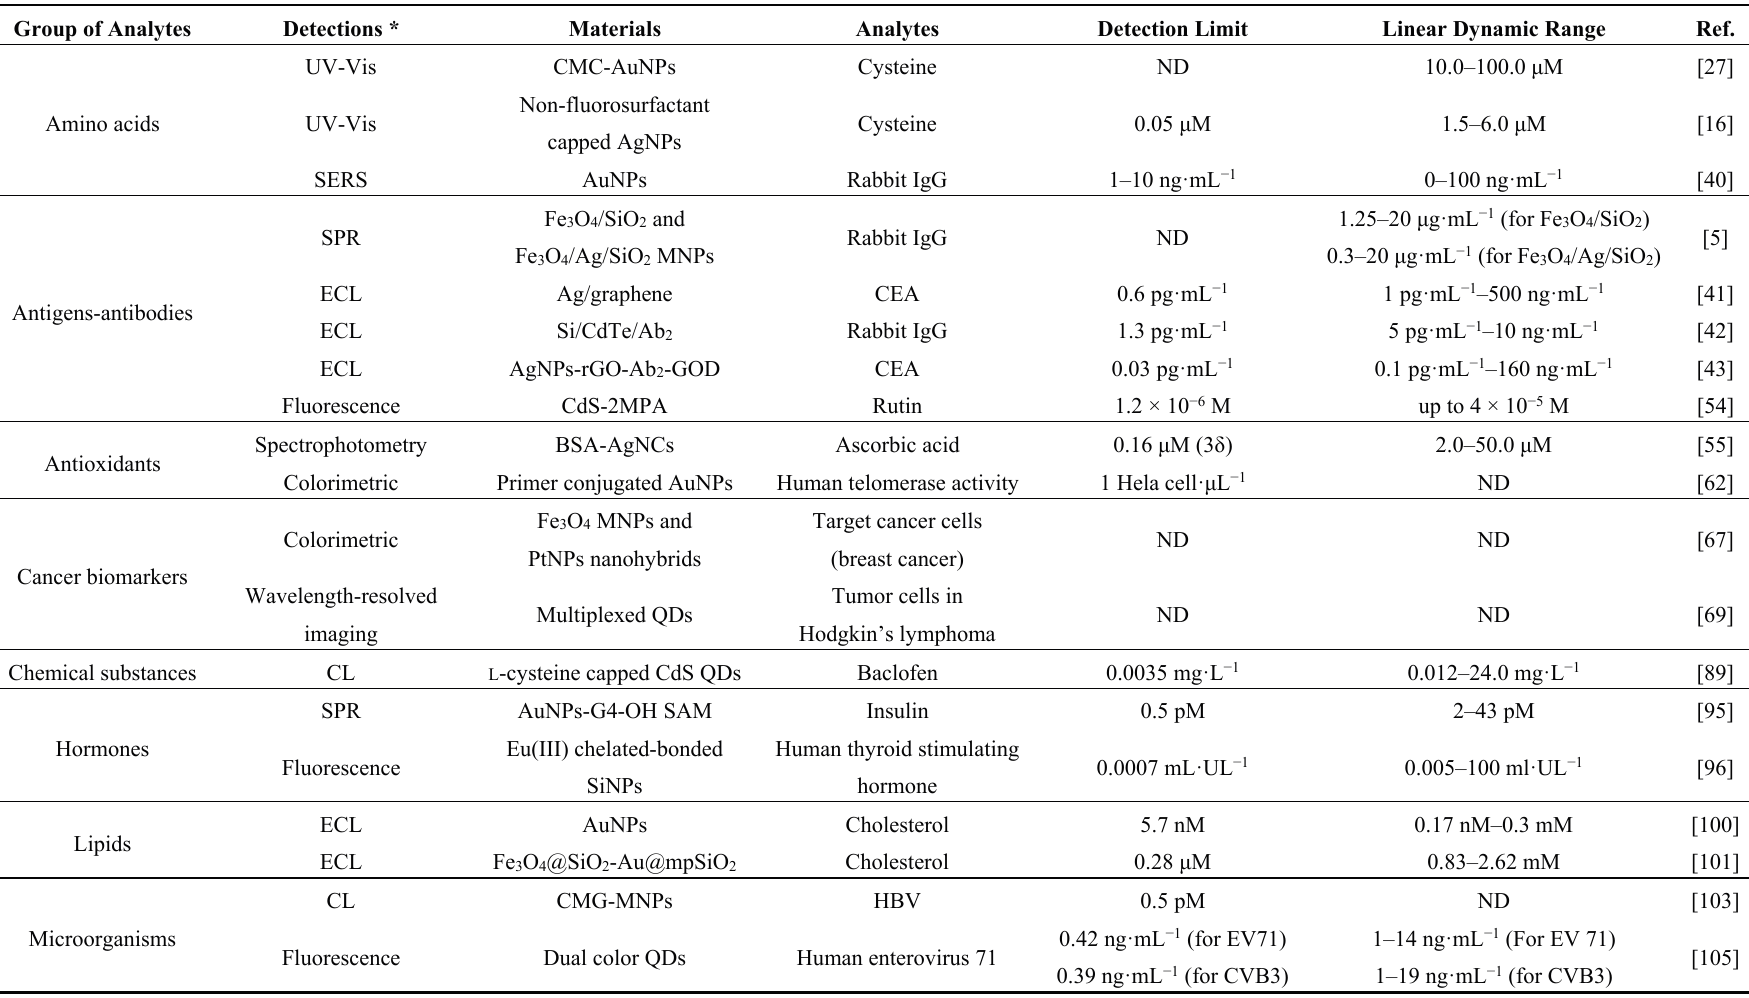
Table 2. Selected examples of recent reports on biomedical targets using various nanoparticles by colorimetric and spectrophotometric